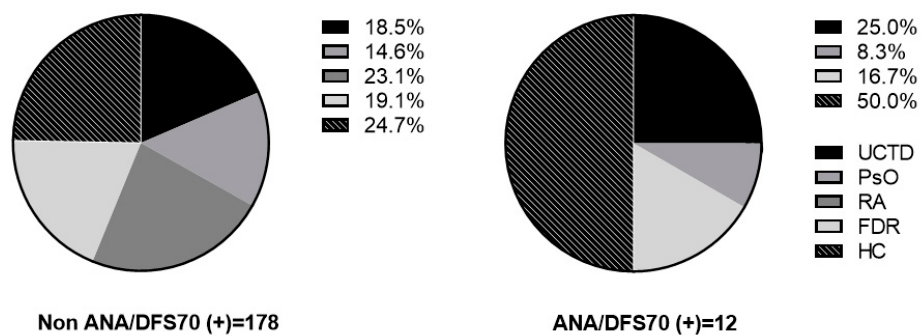
Figure 1. Frequency of participants based on positivity for non-ANA/DFS70 and ANA/DFS70. First degree relatives (FDR), healthy controls (HC), Psoriasis (PsO), Rheumatoid arthritis (RA), and Undifferentiated connective tissue diseases (UCTD).